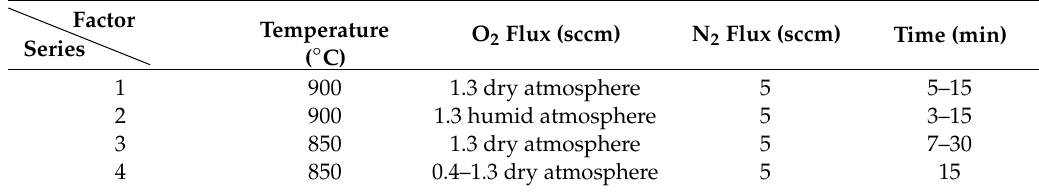
Table 1. Conditions of oxidation.